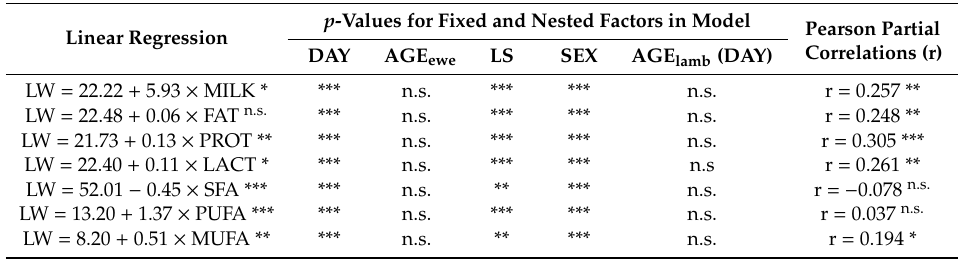
Table 1. Regression-correlation analysis between Wallachian lambs’ live weight and milk production, milk compounds, or fatty acid groups during their rearing. p -Values for Fixed and Nested Factors in Model Linear Regression